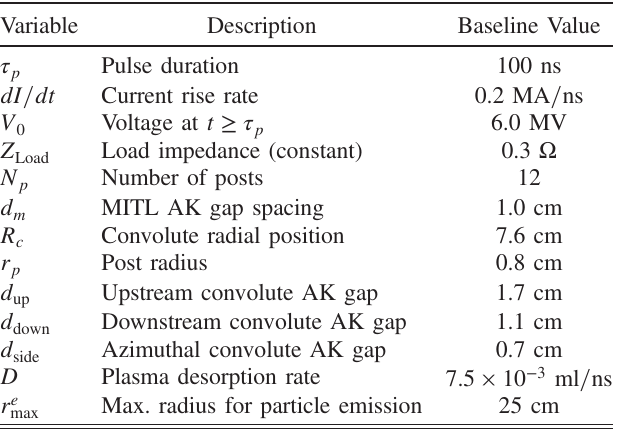
¼ I − I for the three baseline cases; (a) 2*, A Loss Load